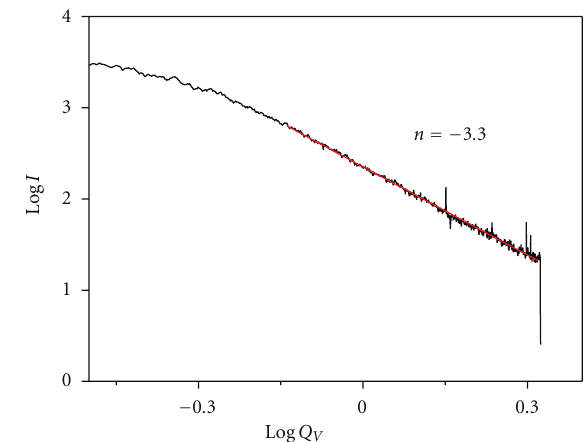
Figure 7: The Porod graph, obtained from the vertical intensity cut of sample B (shown in Figure 5(b)); n is the slope of the fitting line